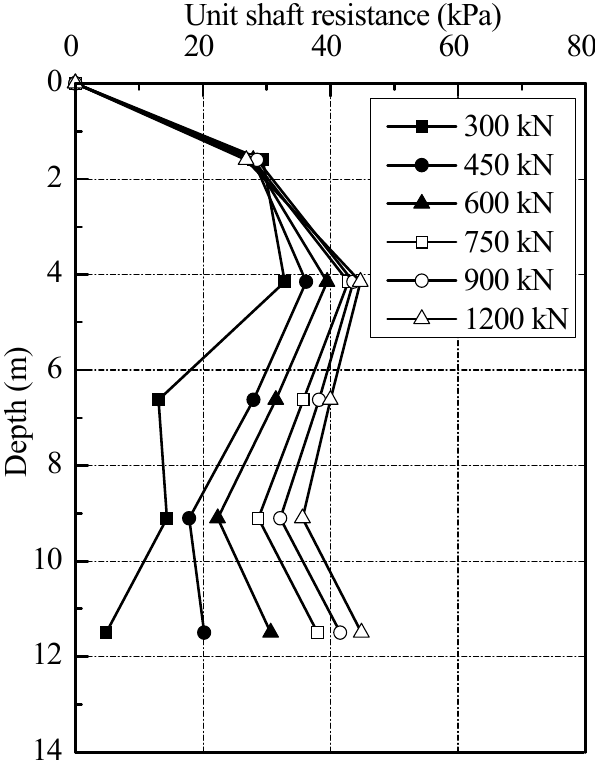
Figure 15. Variation of base and shaft resistance during loading test.